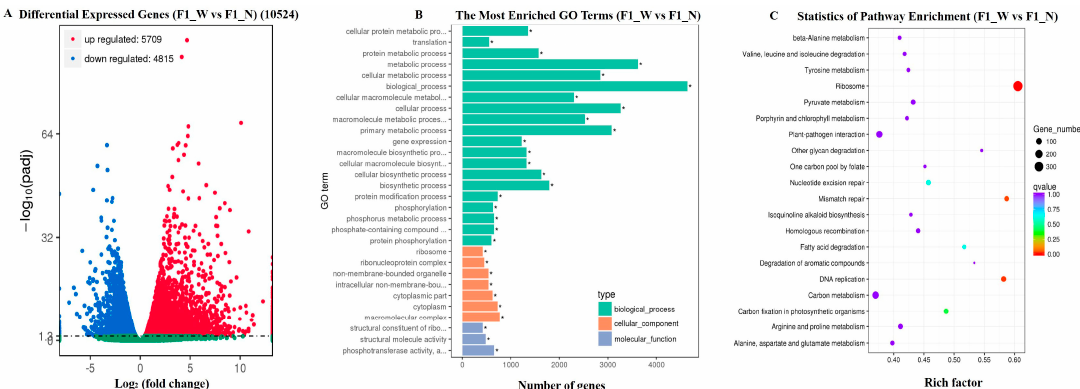
Figure 4. Screening of DEGs and DEG functional analysis. ( A ) Significantly up-or down-regulated genes using the q -value threshold of <0.05; ( B ) GO enrichment analysis of the DEGs; ( C ) The top 20 Kyoto encyclopedia of genes and genomes (KEGG) pathways with the highest representation of DEGs.